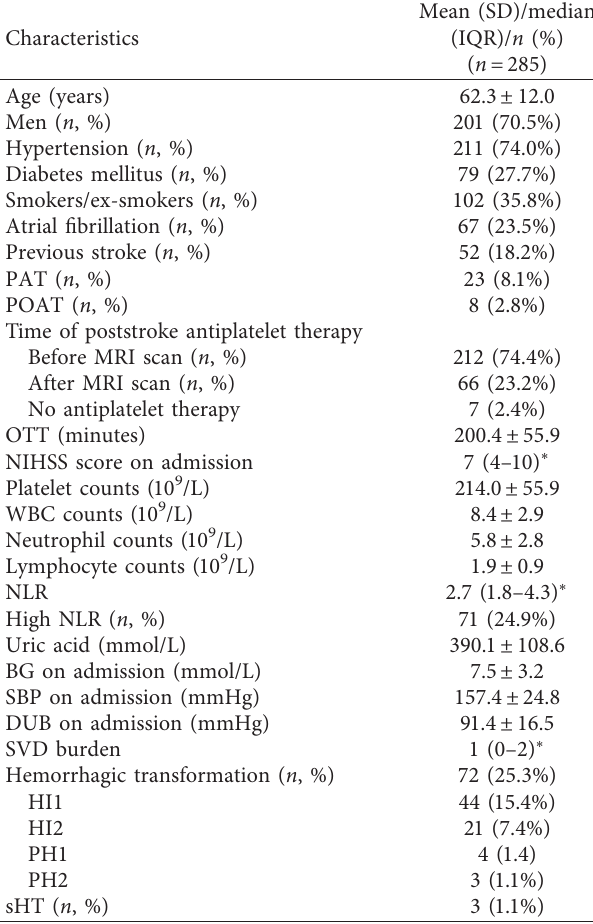
Table 1: Demographic and clinical characteristics of the study